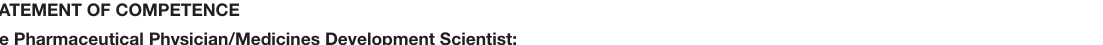
TABLE 1 | Statement of Competence*.